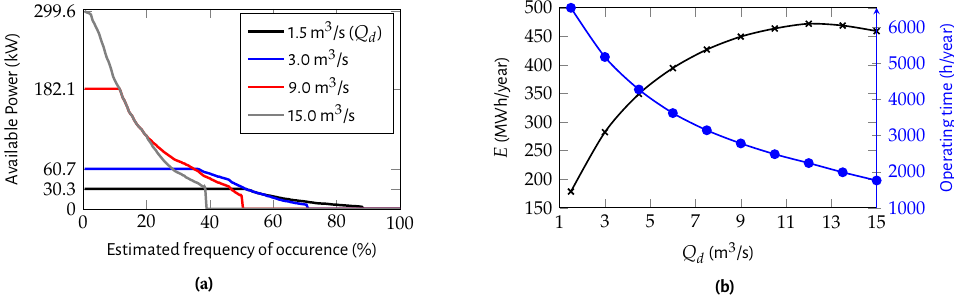
Figure 5. Results for the AST: ( a ) operating discharge; and ( b ) annual harvested and operating